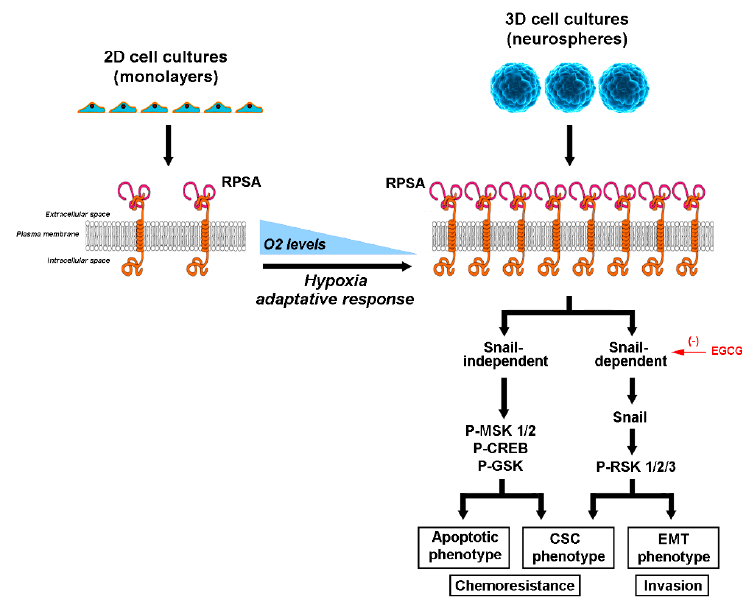
Figure 6. Schematic representation summarizing the crosstalk linking SNAIL to RPSA and the action of EGCG on the neurosphere molecular signature. U87 glioblastoma monolayers (2D cell cultures) can be cultured into 3D neurospheres to recapitulate the CSC invasive and chemo-resistant phenotypes through, in part, the induction of epithelial-to-mesenchymal (EMT) process and adaptative response to low O 2 levels (hypoxia). Neurospheres express increased RPSA levels, contributing to both SNAIL-dependent and SNAIL-independent events. EGCG (red arrow) was demonstrated to target SNAIL-dependent signaling by reducing EMT biomarkers, and RSK phosphorylation, to impede spheroids growth and CSC phenotype. A potential adaptative apoptotic phenotype also involves SNAIL-independent signaling where RPSA regulates the phosphorylation status of MSK/CREB/GSK3 α / β during spheroids formation. Altogether, current EGCG pharmacological intervention against acquiring of a CSC phenotype supports its chemopreventive properties.